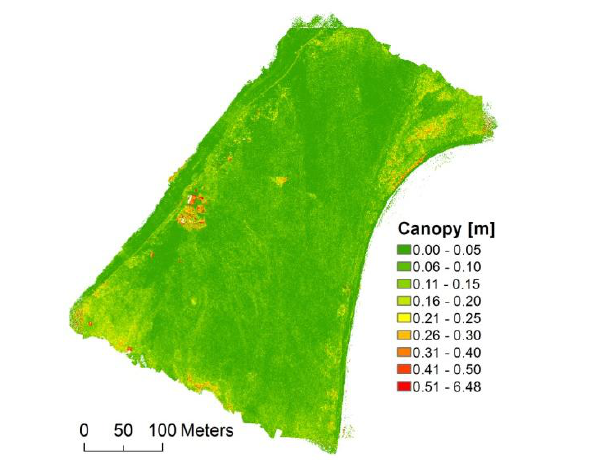
Figure 6. Calculated canopy height from the 3D point cloud